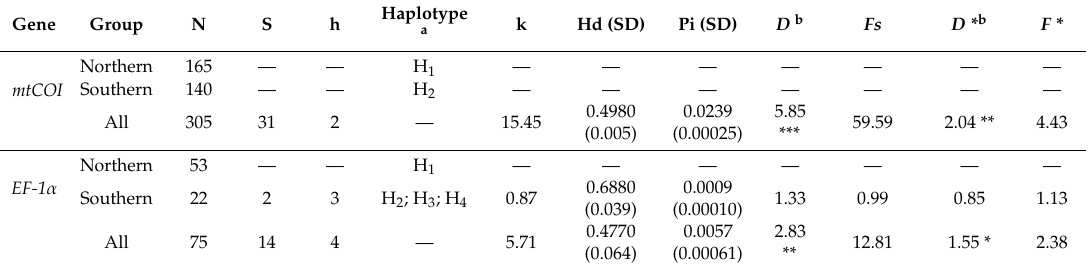
Table 2. Parameters of genetic diversity and demographic analysis of the two population groups.